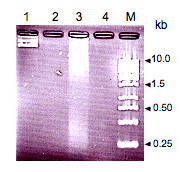
Protection of DNA against DNase I digestion by SASPs binding. The pJIR751 DNA was incubated alone (lane 1), with DNase I (lane 2), with SASPs and DNase I (lane 3) or DNase I in the presence of 8 M urea (lane 4). M indicates the migration of DNA size markers (Gene Ruler™ 1-kb ladder; Fermentas). The results are from representative experiments; these results were highly reproducible (data not shown).